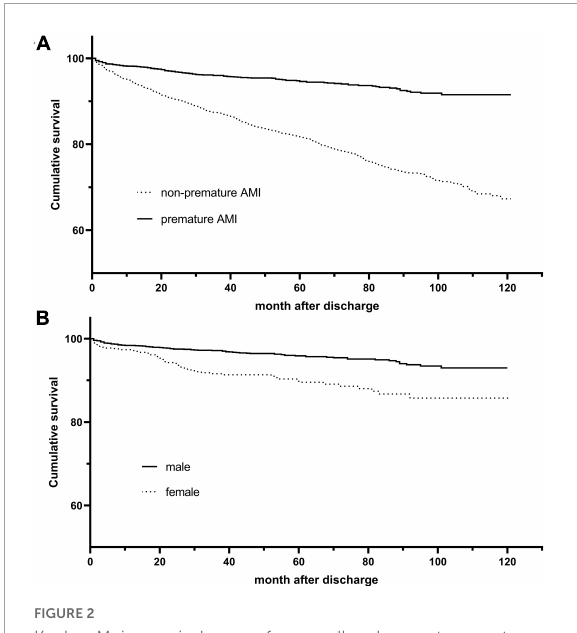
FIGURE2 Kaplan-Meier survival curves for overall and premature acute myocardial infarction (AMI) patients. (A) Kaplan–Meier curves for all-cause death stratified by age group (log-rank, P < 0.001). (B) Kaplan–Meier curves for all-cause death stratified by gender (log-rank, P < 0.001).